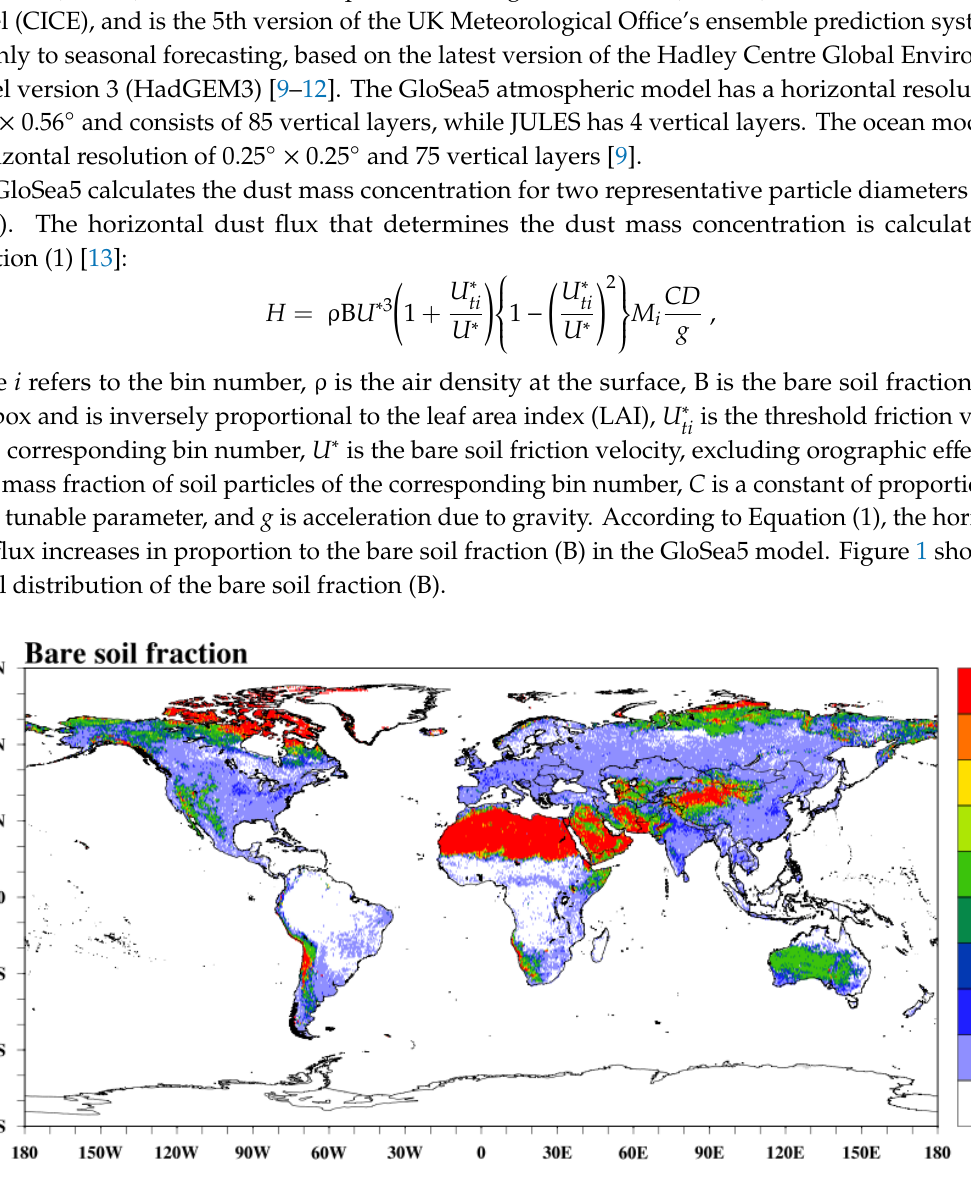
Figure 1. The global distribution of the bare soil fraction ( B ) in the Global Seasonal Forecasting Model version 5 (GloSea5).